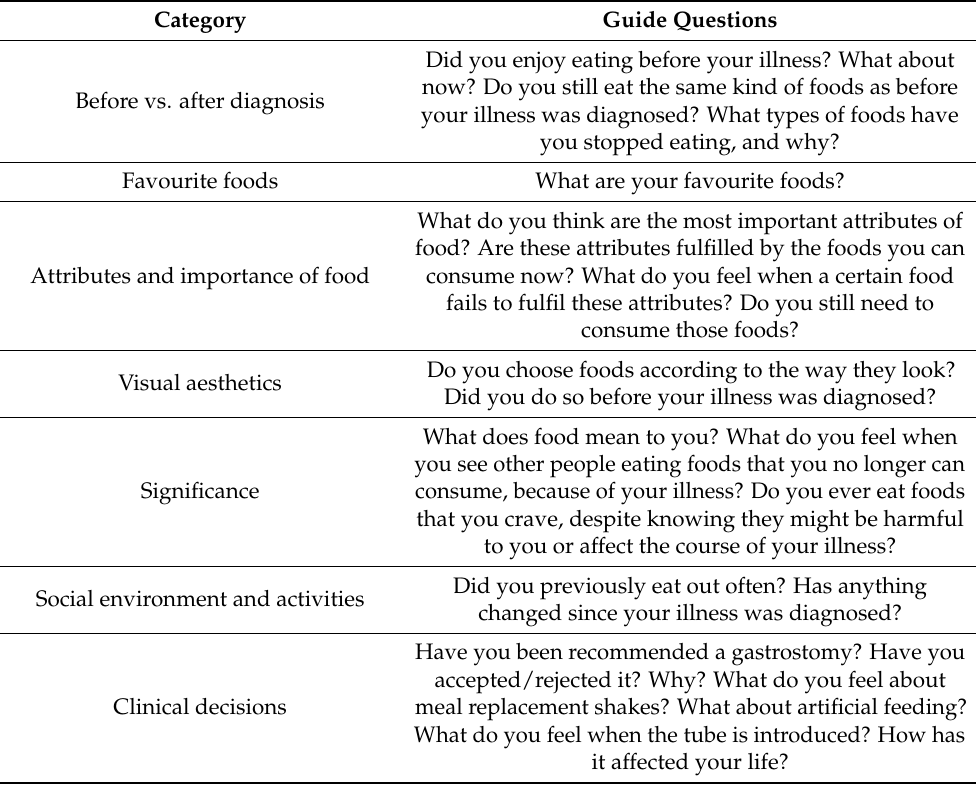
Table 2. In-depth interviews: categories and guide questions.